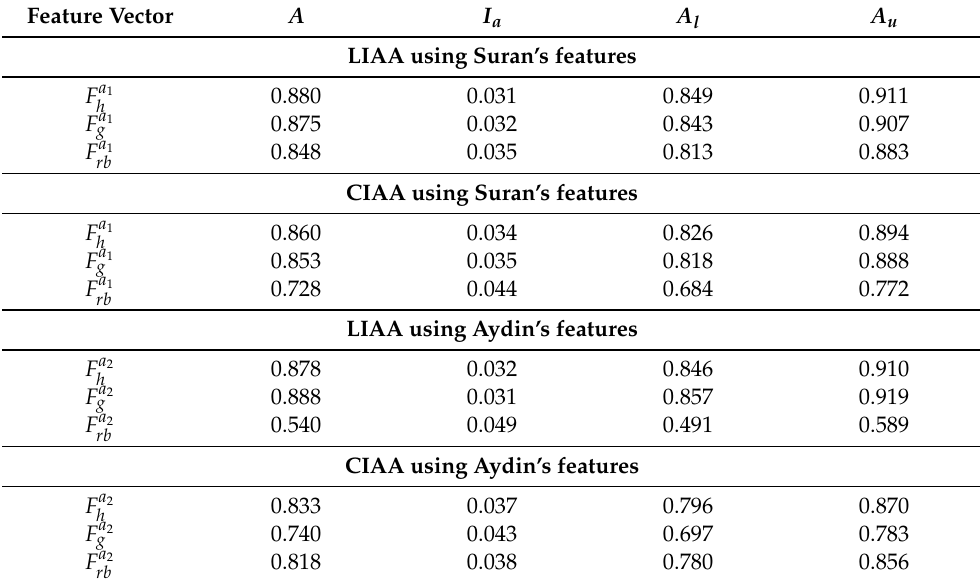
Table 12. Evaluations of LIAA, CIAA using Suran’s and Aydin’s global features, RB features and both global features and RB